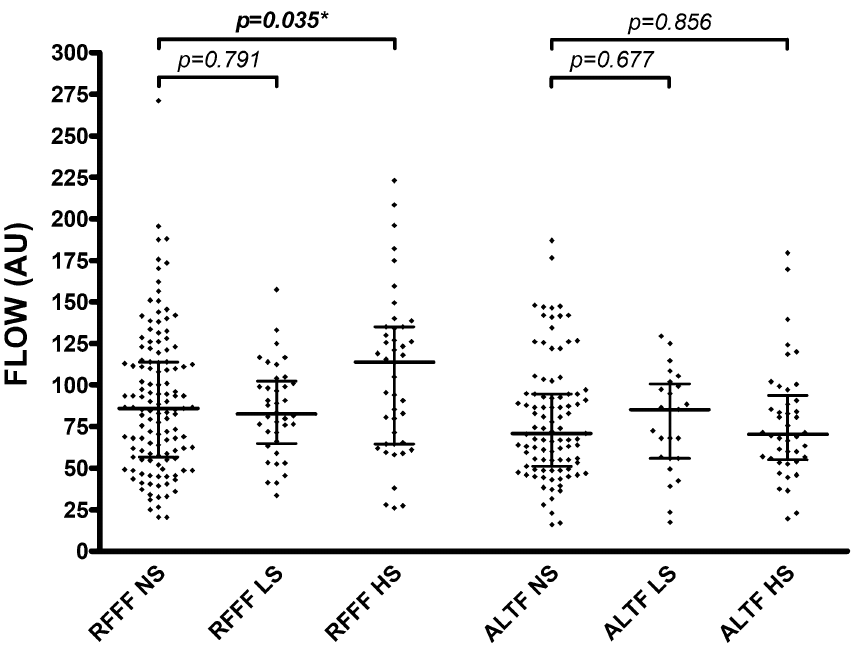
Figure 2. Postoperative perfusion measurement. Each dot represents an individual blood flow (AU) with median (center line) and 1. and 3. quartile (upper and lower lines) for postoperative measurement (separately described for the group of nonsmokers (NS), the group of light smokers (LS) and the group of heavy smokers (HS)); p values corresponding to testing for differences with Mann Whitney test; significant p values are bold (* p = 0.046 with adjustment for sex, age, BMI, diabetes, mean arterial pressure and catecholamine dose); RFFF radial free forearm flap, ALTF anterolateral thigh flap, NS nonsmokers, LS light smokers, HS heavy smokers, AU arbitrary